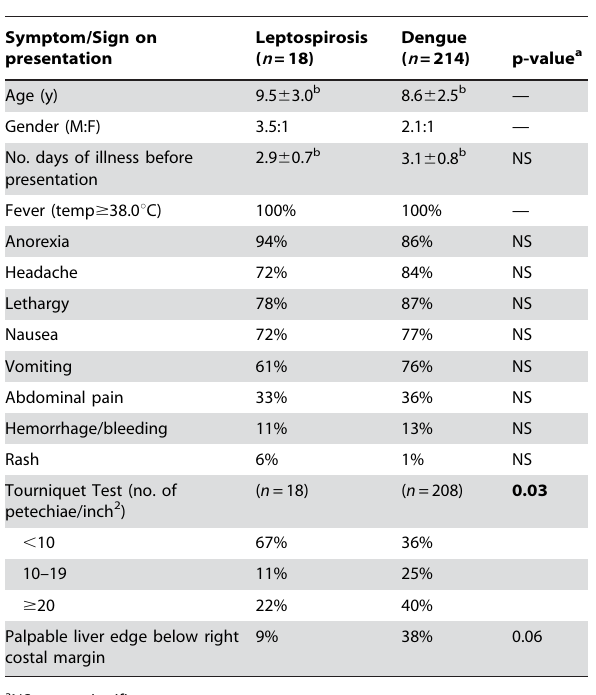
Table 2. Case-control comparison of presenting symptoms and signs between children with leptospirosis and dengue.